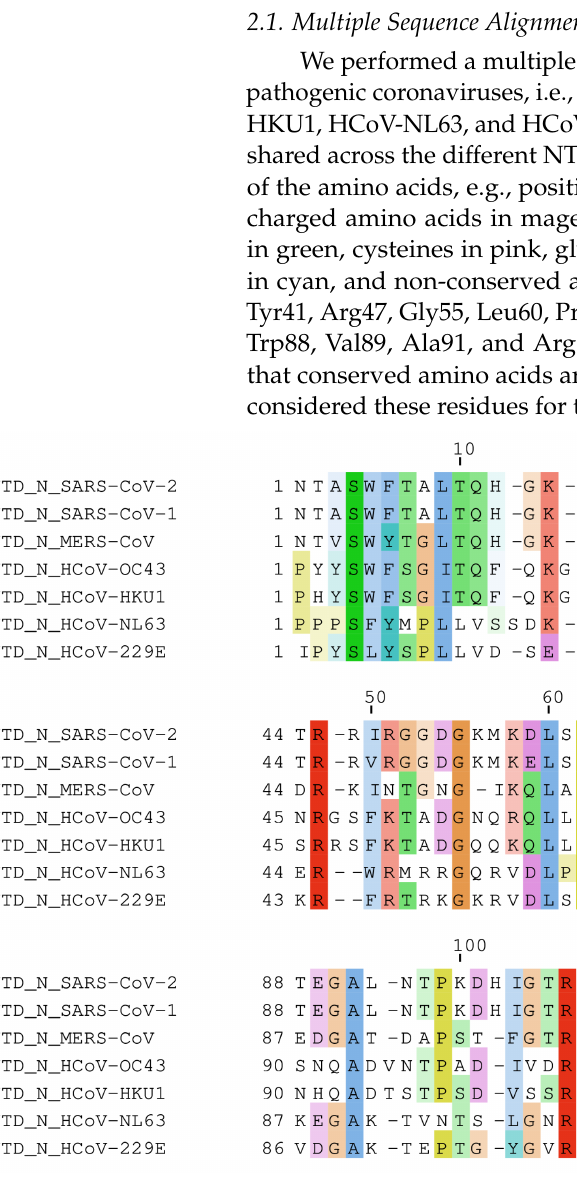
Figure 1. Multiple sequence alignment between the NTD of the nucleocapsid proteins of 7 different coronaviruses, i.e., SARS-CoV-2 (PDB: P0DTC9), SARS-CoV-1 (PDB: P59595), MERS-CoV (I PDB: K9N4V7), HCoV-OC43 (PDB: P33469), HCoV-NL63 (PDB: Q6Q1R8), HCoV-229E (PDB: P15130), and HCoV-HKU1 (PDB: